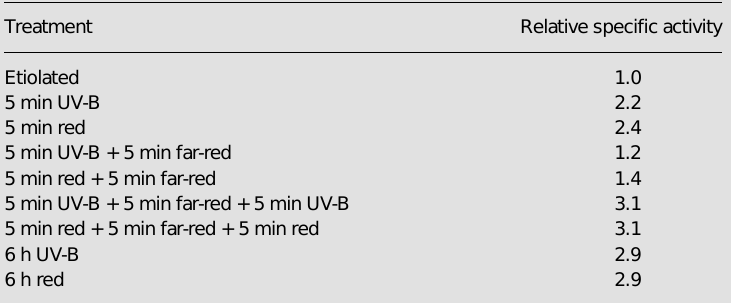
Table 3 - Effects of UV-B, red and far-red light pulses on the specific activity of NADP- ME from etiolated seedlings. The specific activity of each sample is presented relative to the specific activity assayed in etiolated plants (0.053 U/mg) (according to Ref. 31).